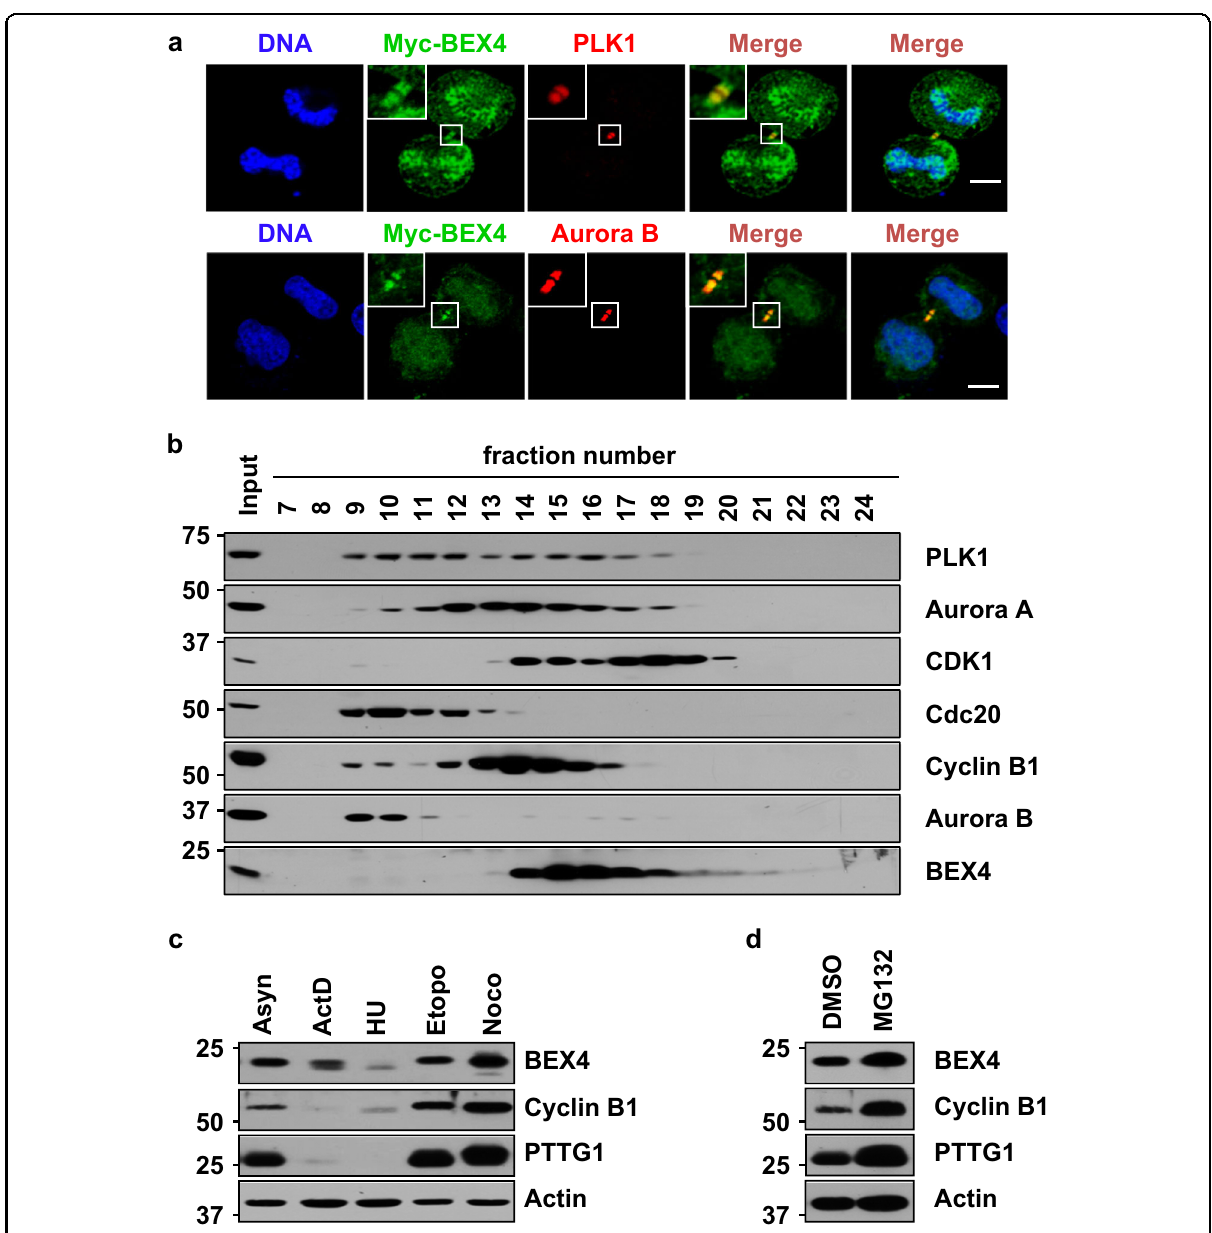
Fig. 1 Localization and expression of BEX4 proteins in mitosis. a HeLa cells expressing Myc-tagged BEX4 were stained with anti-Myc, anti-PLK1, and anti-aurora B antibodies, as indicated. Scale bars represent 5 μ m. The insets show magni fi ed images of cells at midbody. b Extracts were prepared from HeLa cells synchronized at mitosis by nocodazole and fractionated by gel fi ltration using a Superdex-200 column. Fractions (numbered 7 – 24) were analyzed by immunoblotting using antibodies against PLK1, aurora A, CDK1, Cdc20, cyclin B1, aurora B, and BEX4. Input indicates 4% of the extract. c BEX4 expression levels are shown in different phases of the HeLa cell cycle. HeLa cells were synchronized by 5 nM Actinomycin D (ActD, G1- phase), 75 μ g/mL hydroxyurea (HU, S-phase), 0.5 μ M etoposide (Etopo, G2/M-phase), and 200 ng/ml nocodazole treatment (Noco, M-phase) for 16 h. The lysates were analyzed by immunoblotting using anti-BEX4, anti-cyclin B1, anti-PTTG1, and anti-actin antibodies. d HeLa cells were treated with the proteasome inhibitor MG132 (10 μ M). After 6 h, the cells were harvested and subjected to immunoblotting with anti-BEX4, anti-cyclin B1, anti- PTTG1, and anti-actin